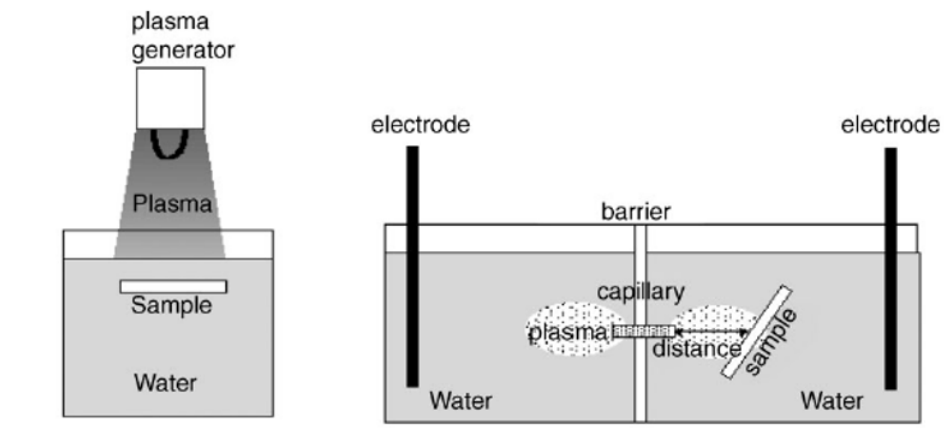
Figure 4. The experimental setup for reatment of materials’ surface by GDEP (Adapted from